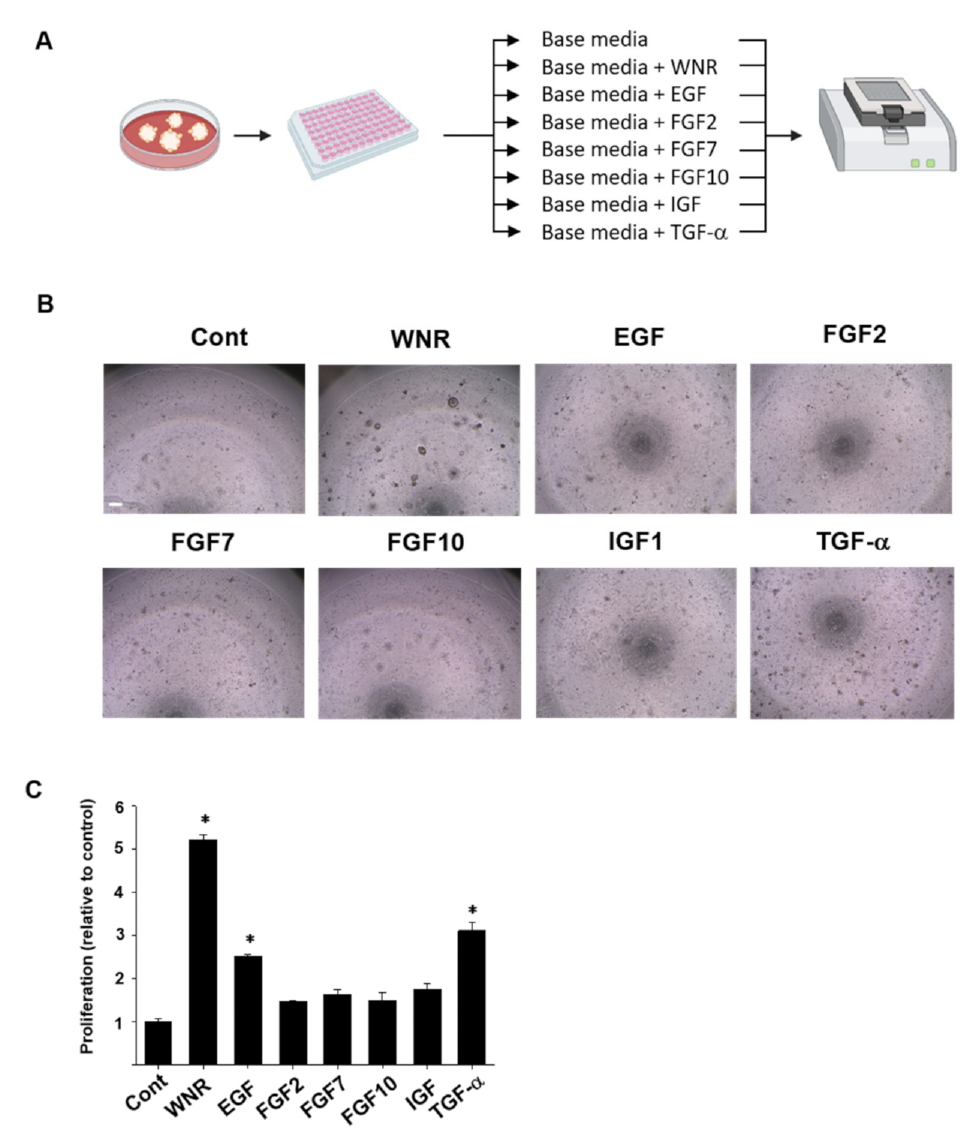
Figure 3. Identification of suitable culture supplements for intestinal organoids from the rousette bat. Experimental schema of identifying suitable media components of rousette bat organoids ( A ). Phase-contrast images of the growth of rousette bat intestinal organoids cultured in base medium alone (Cont) or with different culture supplements. WNR indicates Wnt 3a, Noggin, and R-spondin. Scale bar: 500 µ m ( B ). Cell proliferation ratio of organoids in each culture media ( C ). The results were shown as a fold increase relative to control and expressed as mean ± S.E.M. * p < 0.05 vs.